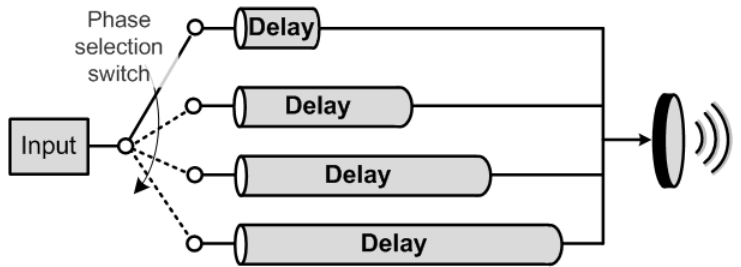
Figure 4. A simple phase shifter using switchable delay lines.